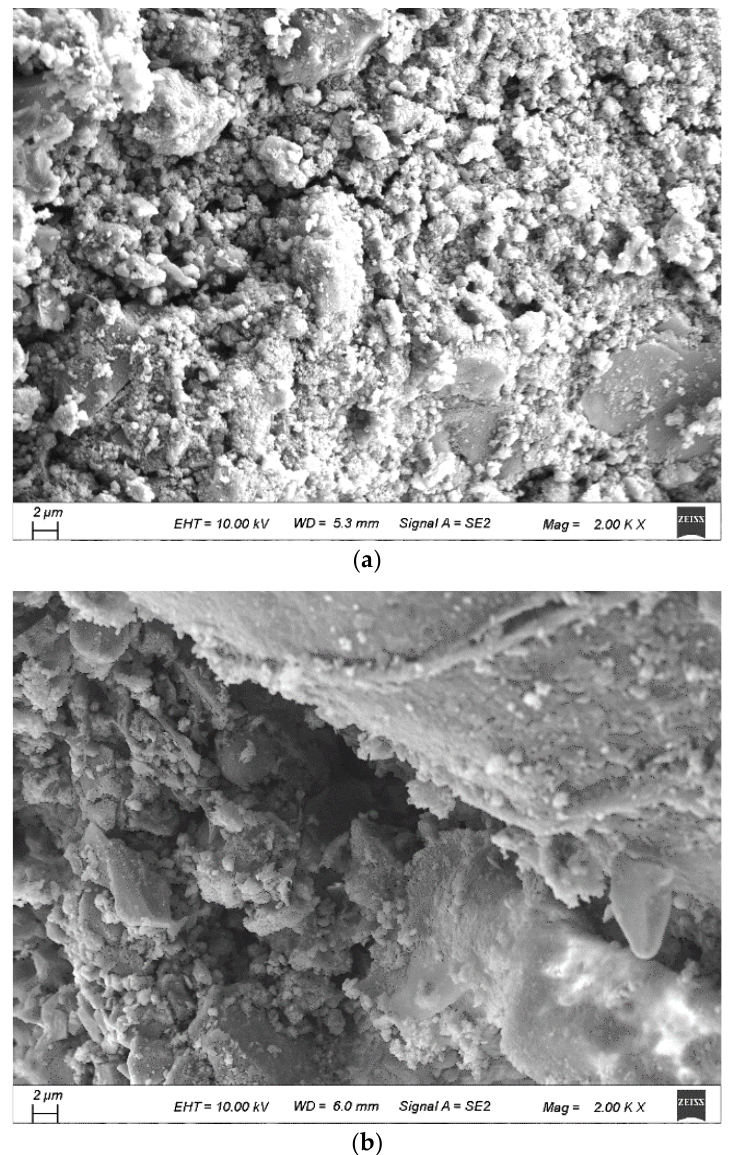
Figure 16. Images of the raw RCA obtained with optical microscope (magnification: 40). ( a ) Pore; ( b ) adhered mortar.